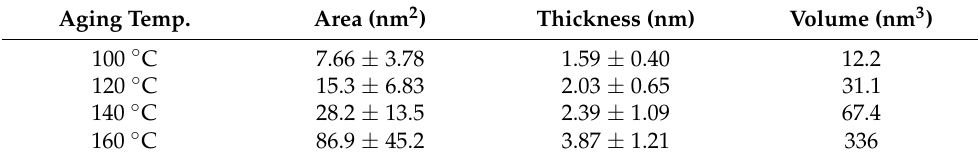
Table 5. Average sizes of η (cid:48) precipitate of 7075-HCu subjected to different PA conditions. Aging Temp.